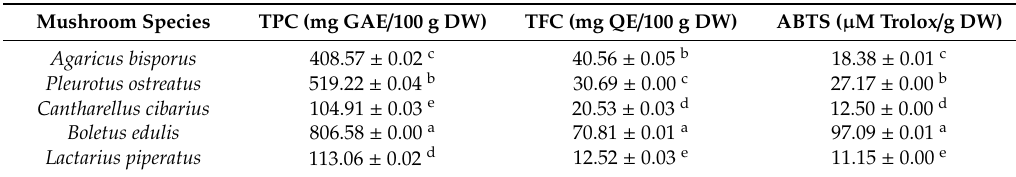
Table 1. Total phenolic content (TPC), total flavonoid content (TFC), and antioxidant activity (ABTS + ) of the mushroom